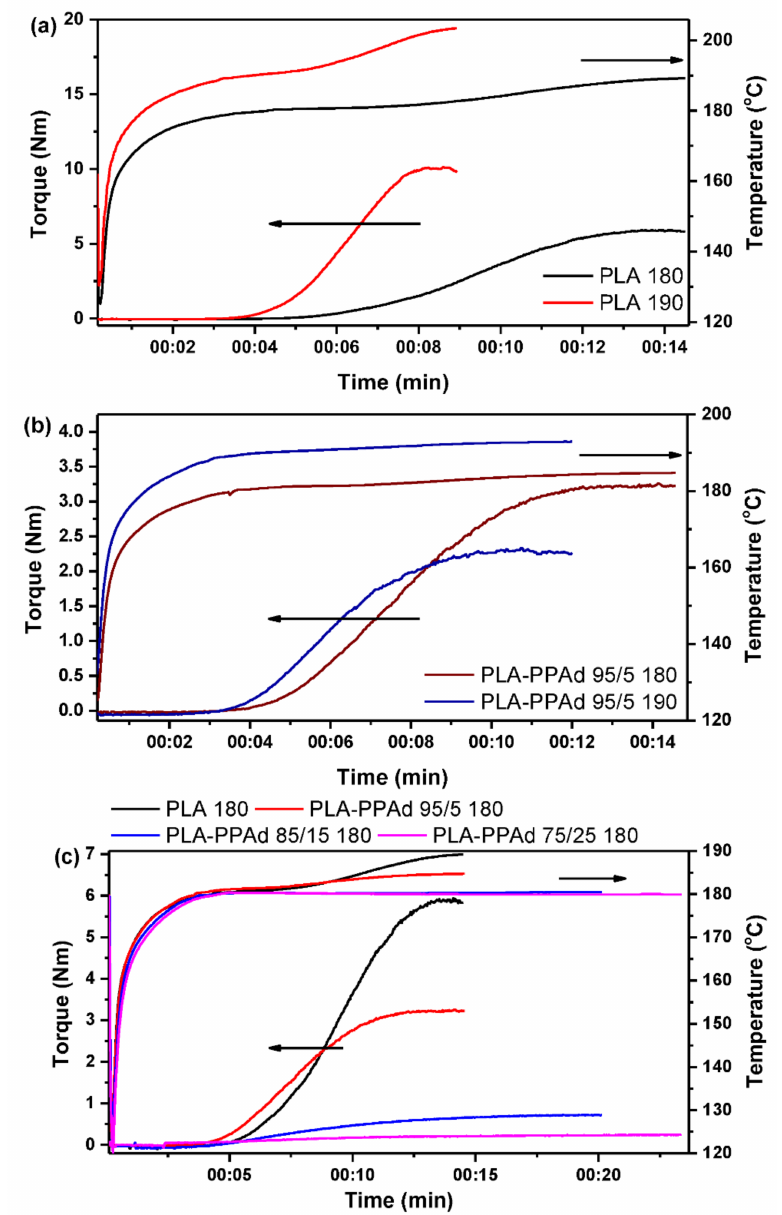
Figure 1. Torque/temperature curves for ( a ) ROP of L-lactide at 180 ◦ C and 190 ◦ C, ( b ) ROP of PLA initiated by PPAd (5 wt%) at 180 ◦ C and 190 ◦ C, ( c ) ROP of PLA initiated by PPAd at 5 wt%, 15 wt% and 25 wt% at 180 ◦